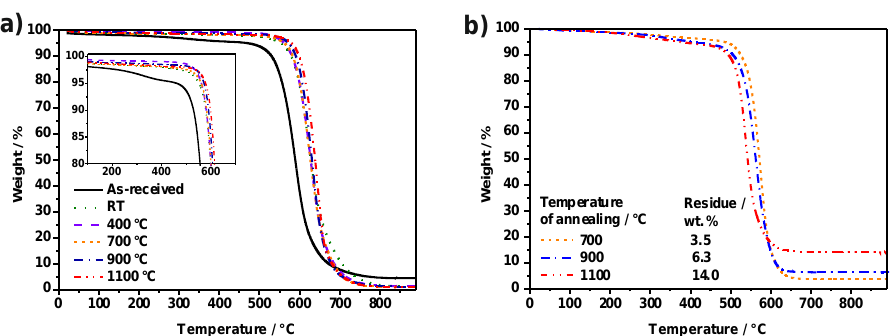
Figure 3. Thermogravimetric analyses of: ( a ) as-received, purified (RT) and annealed SWCNTs (at 400, 700, 900, and 1100 °C); and ( b ) SWCNTs filled with EuCl 3 at selected temperatures. Measurements were performed under air flow.